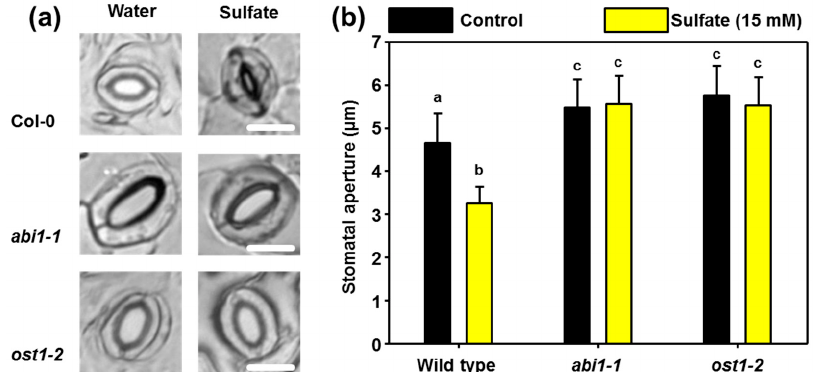
Figure 1. Functional ABI1 and OST1 are essential for sulfate-induced stomatal closure in Arabidopsis. ( a ) Representative guard cell in epidermal peels of 5-weeks–old soil-grown wild-type, abi1-1 , and ost1-2 plants that were floated on water at pH 5.5 or water supplemented with sulfate (15 mM MgSO 4 ) for three hours. ( b ) Quantification of the stomatal aperture of guard cells in epidermal peels from plants indicated in (a) that were treated with water (control, black) supplemented with sulfate (15 mM, yellow). Letters indicate statistically significant differences between groups determined with the one Way ANOVA test ( p < 0.05, n = 50 stomata, derived from epidermal peels of five individual plants). Values represent means ± standard deviation (SD). Scale bar, 10 µ m.